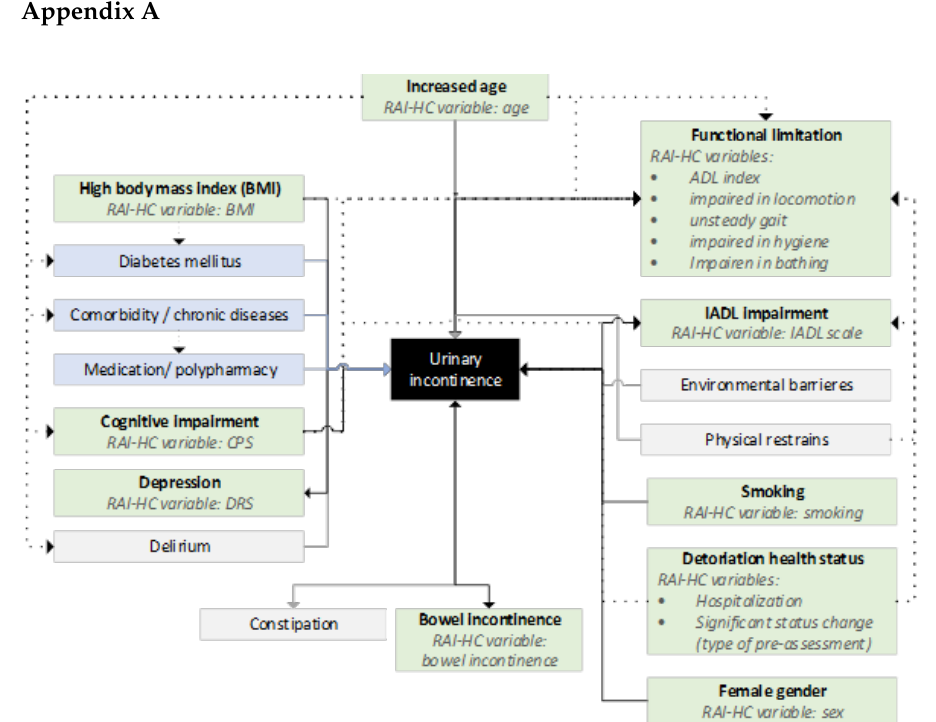
Figure A1. Risk factors of urinary incontinence identified in the scientific literature. Risk factors marked in green were operationalized using the database HomeCareData. Risk factors marked in blue could not be operationalized based on the available data and risk factors marked in grey were factors influenceable by the provider and therefore not suitable for risk adjustment. Abbreviations: ADL, Activities of daily living; BMI, Body Mass Index; IADL, Instrumental activities of daily living; DRS, Depression Rating Scale; CPS, Cognitive Performance Scale.